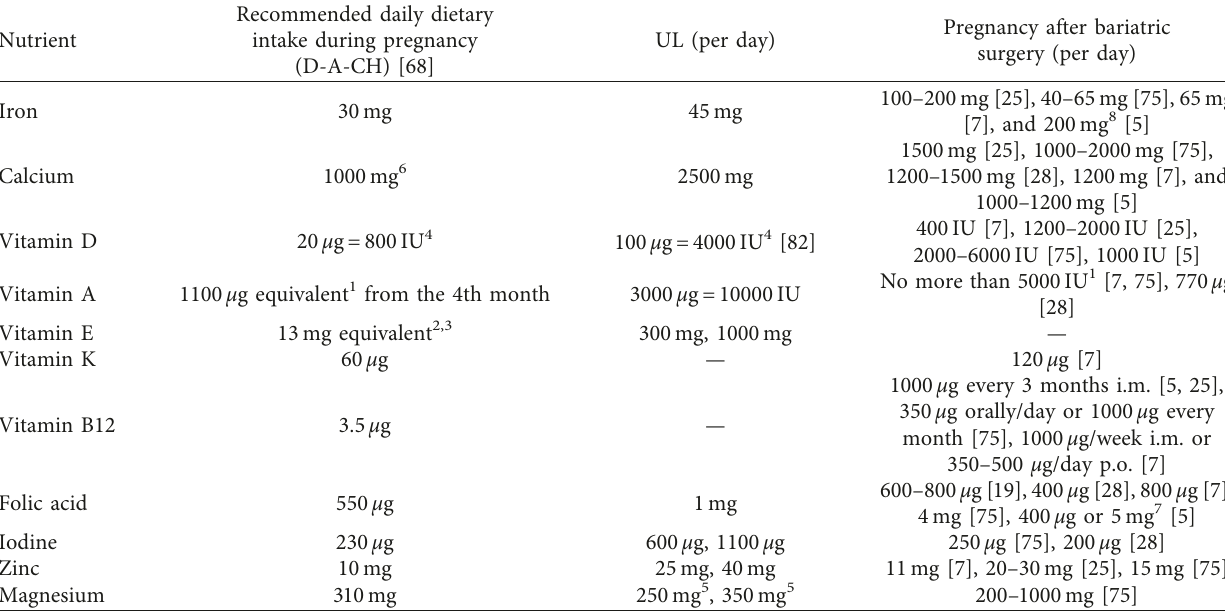
Table 4: D-A-CH recommendations for supplementation of nutrients in pregnancies [68], tolerable upper intake levels according to EFSA [26] in pregnancy, and further nutritional recommendations in pregnancies after bariatric surgery according to Schultes et al. [25], Kaska et al. [75], Gonzalez et al. [28], Quyang et al. [7], Kushner et al. [62], ACOG [19], and Busetto et al.